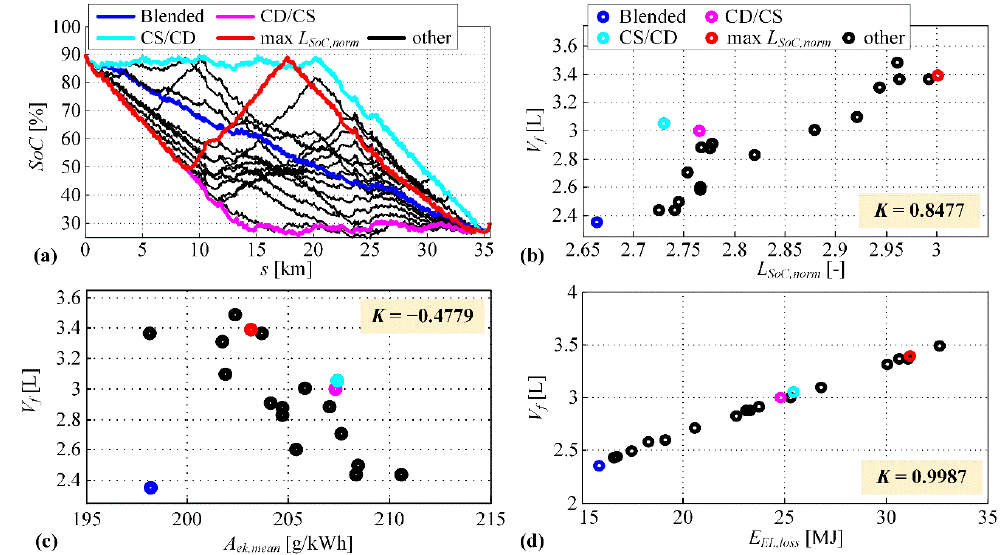
Figure A1. ( a ) DP-optimal SoC trajectories of di ff erent length, ( b ) corresponding fuel consumptions V f Figure 18. ( a ) DP-optimal SoC trajectories of different length, ( b ) corresponding fuel consumptions given versus: normalized SoC trajectory length L SoC , norm , ( c ) mean specific fuel consumption A ek , mean 𝑉 (cid:3033) given versus: normalized SoC trajectory length 𝐿 (cid:3020)(cid:3042)(cid:3004),(cid:3041)(cid:3042)(cid:3045)(cid:3040) , ( c ) mean specific fuel consumption 𝐴 (cid:3032)(cid:3038),(cid:3040)(cid:3032)(cid:3028)(cid:3041) and ( d ) total electric energy losses 𝐸 (cid:3006)(cid:3013),(cid:3039)(cid:3042)(cid:3046)(cid:3046) (3xDUB driving cycle without road grade is and ( d ) total electric energy losses E EL , loss (3xDUB driving cycle without road grade is considered; K is considered; K is the correlation index). the correlation